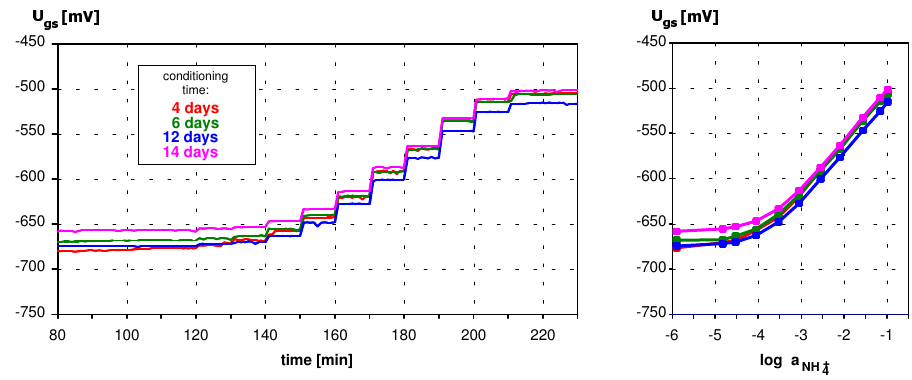
Figure 8. Dynamic responses and calibration curves of an ammonium ion sensor with membrane of Siloprene K 1000, fabricated on ISFET structure with silicon nitride gate